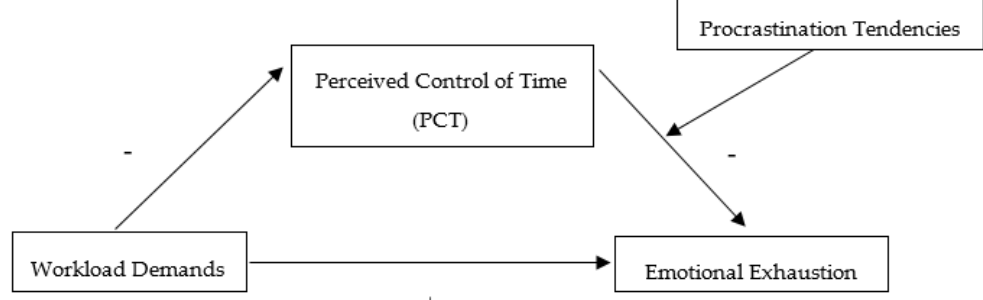
Figure 1. The proposed moderated mediation model.